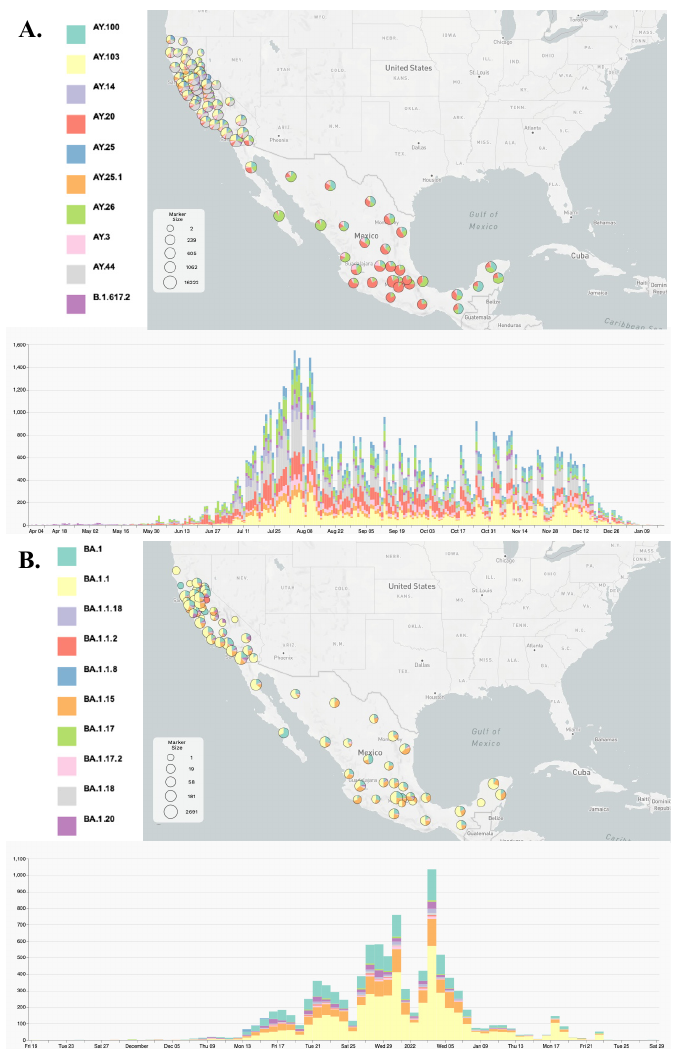
Figure 1. Visualization of the ten most prevalent Delta ( A ) and Omicron ( B ) genomes using MicroReact. MicroReact [15] display of the geolocation of the ten most prevalent genomes with associated lineage inferred by the Pangolin assignment tool [18]. See also Supplementary Figure S4 and MicroReact projects https://microreact.org/project/rqnwd9nymcvdkvq1dktbfj and https://microreact.org/ project/d5mbblhkwgxctofu6wdtxt for all circulating Delta and Omicron sub-variants,